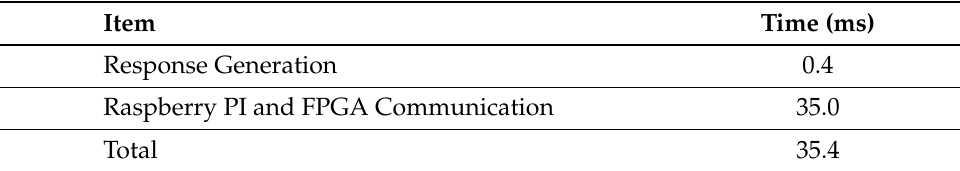
Table 5. CRP generation and communication time.